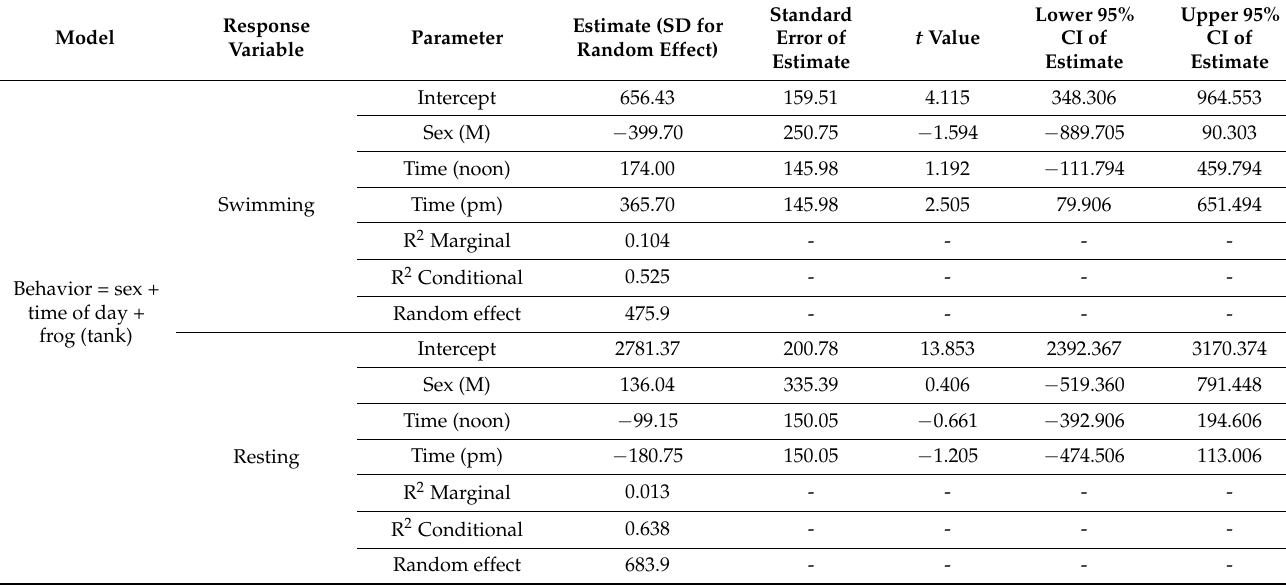
Table 4. Effect parameters from linear mixed models of baseline behaviors, as a factor of sex and time of day, and of behaviors as a factor of sex and health